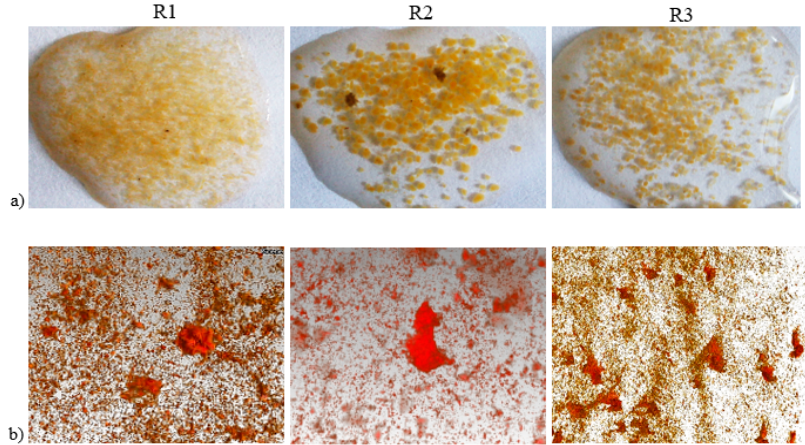
Figure 4. Characteristic biomass: photographs ( a ) and X-ray tomography images ( b ) of granules after 89 days of granulation.